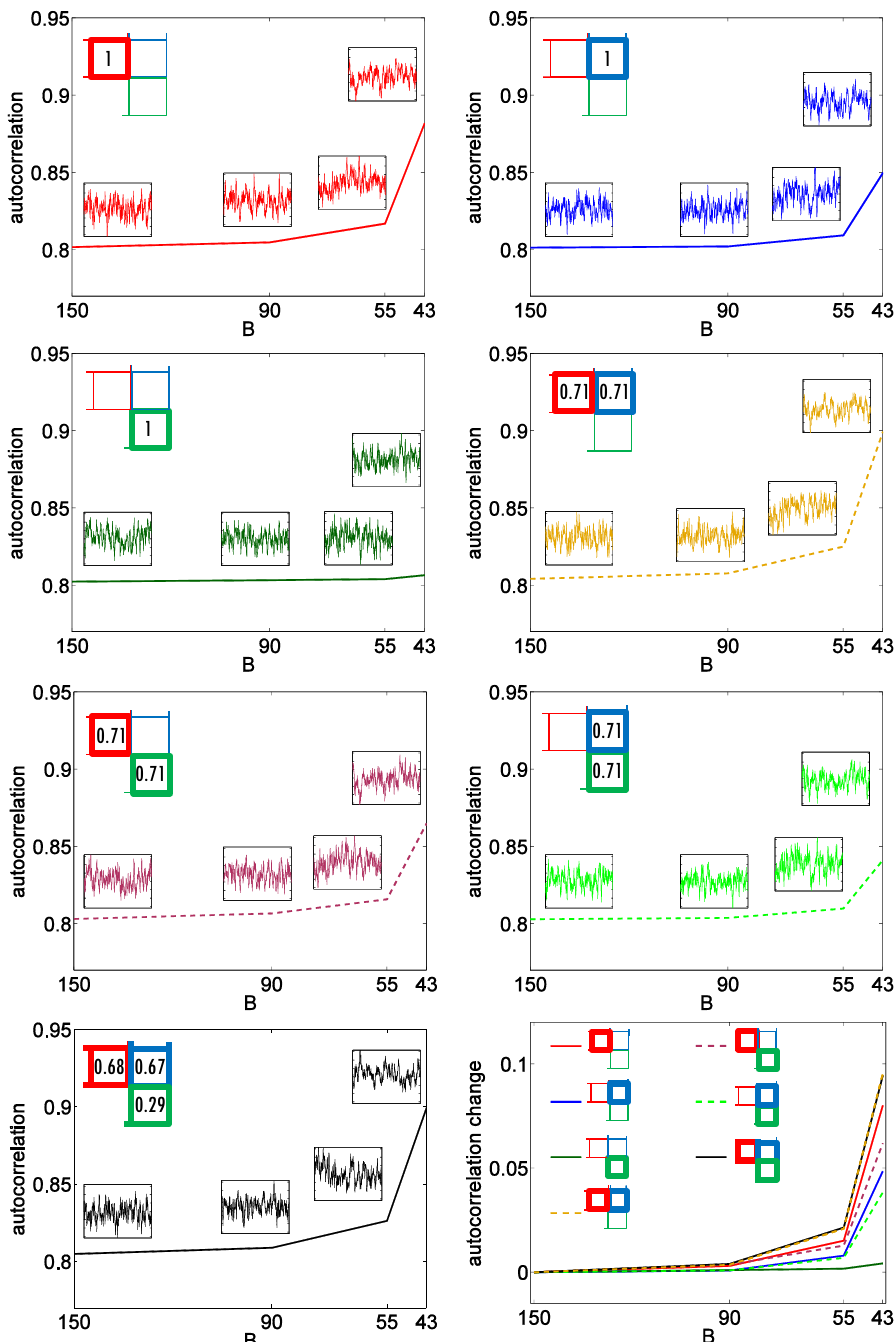
Fig. 7. Example to illustrate the hotspot detection scheme using elements 19, 20, and 25 of system 3. All panels except bottom right: in each top left corner the particular area is highlighted by bold lines. The numbers inside the elements give the eigenvectors of the correlation matrix (EOF) for B = 43. All four time slices (forcings BV1 as in Fig. 5) are projected on this EOF. The four time series in each panel show a chunk of 500 yr from these projections (normed to standard deviation 1 and mean 0). The autocorrelation at lag 1 for each projection is depicted as a line plot in dependency on B . Bottom right: all seven curves are shifted to 0 at B = 150 in order to compare the signals of the areas. Parameter settings correspond to set 1 in Table